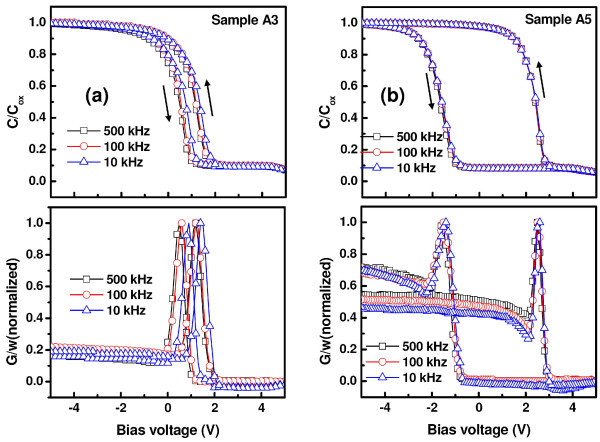
(Color online) Frequency dependent C-V and G-V characteristics. Frequency-dependent C-V and G-V characteristics of Al/SiN/HfO2/SiO2/Si MIS structures with Ge+ implanted at two different energies (a) 3 keV (sample A3) and (b) 5 keV (sample A5) taken in the frequency range of 10-500 kHz